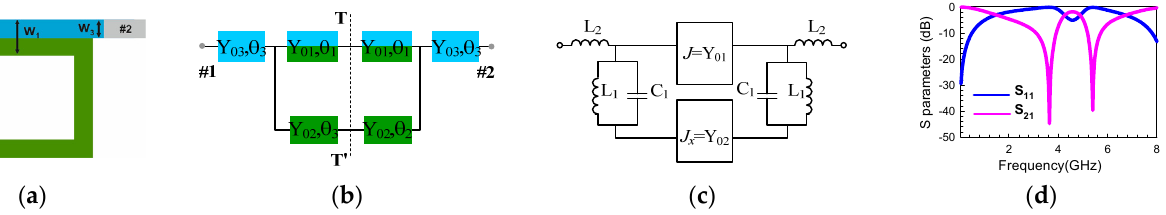
Figure 3. ( a ) A bandpass filter circuit by using square loop resonator ( b ) TL model ( c ) LE model ( d ) frequency response.